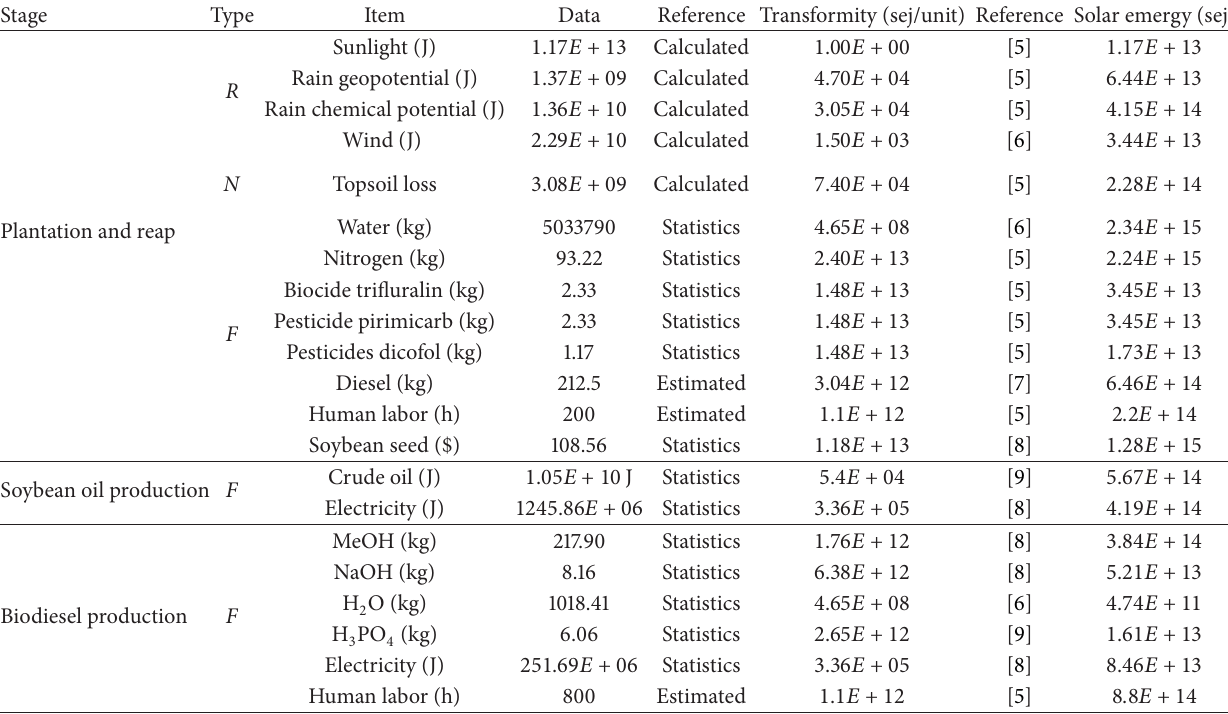
Table 3: Emergy analysis table for soybean-based biodiesel.